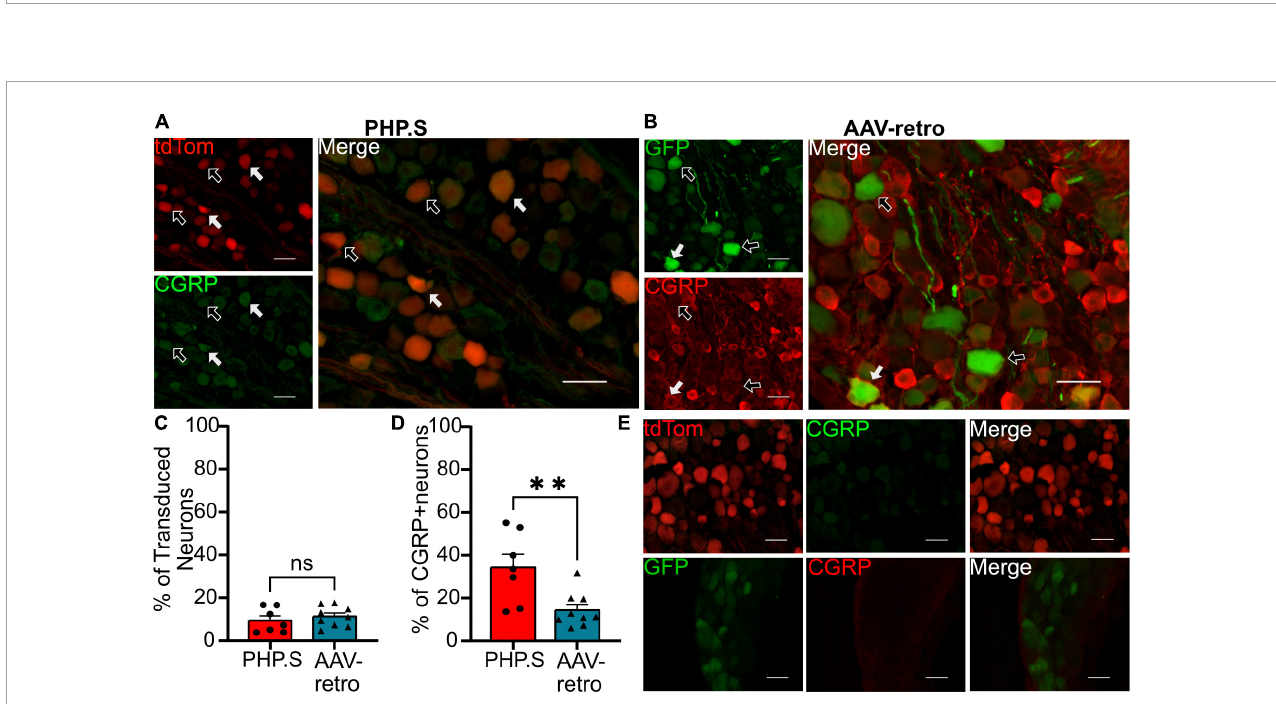
FIGURE8 PHP.S and adeno-associated viruses (AAV)-retro transduces small, peptidergic neurons at similar rates. (A) Representative images of tdTomato expression colocalizing with calcitonin gene-related peptide (CGRP) + neurons in dorsal root ganglia from PHP.S-injected rats (scale bar, 50 µ m). (B) Representative images of GFP expression colocalizing with CGRP + neurons in dorsal root ganglia from AAV-retro-injected rats (scale bar, 50 µ m). (C) Percent of transduced neurons that were CGRP + ( p = 0.4728). (D) Percent of CGRP + neurons that were transduced ( ∗∗ p = 0.0066). (E) Images of dorsal root ganglia from rats injected with PHP.S (top) or AAV-retro (bottom) stained with secondary antibody only for the corresponding fluorophore used for CGRP in experimental tissue. Statistics were performed using the student’s t -test to compare PHP.S ( n = 7) and AAV-retro ( n = 9). White arrows indicate neurons with colocalization; black arrows with a white outline indicate viral transduced without